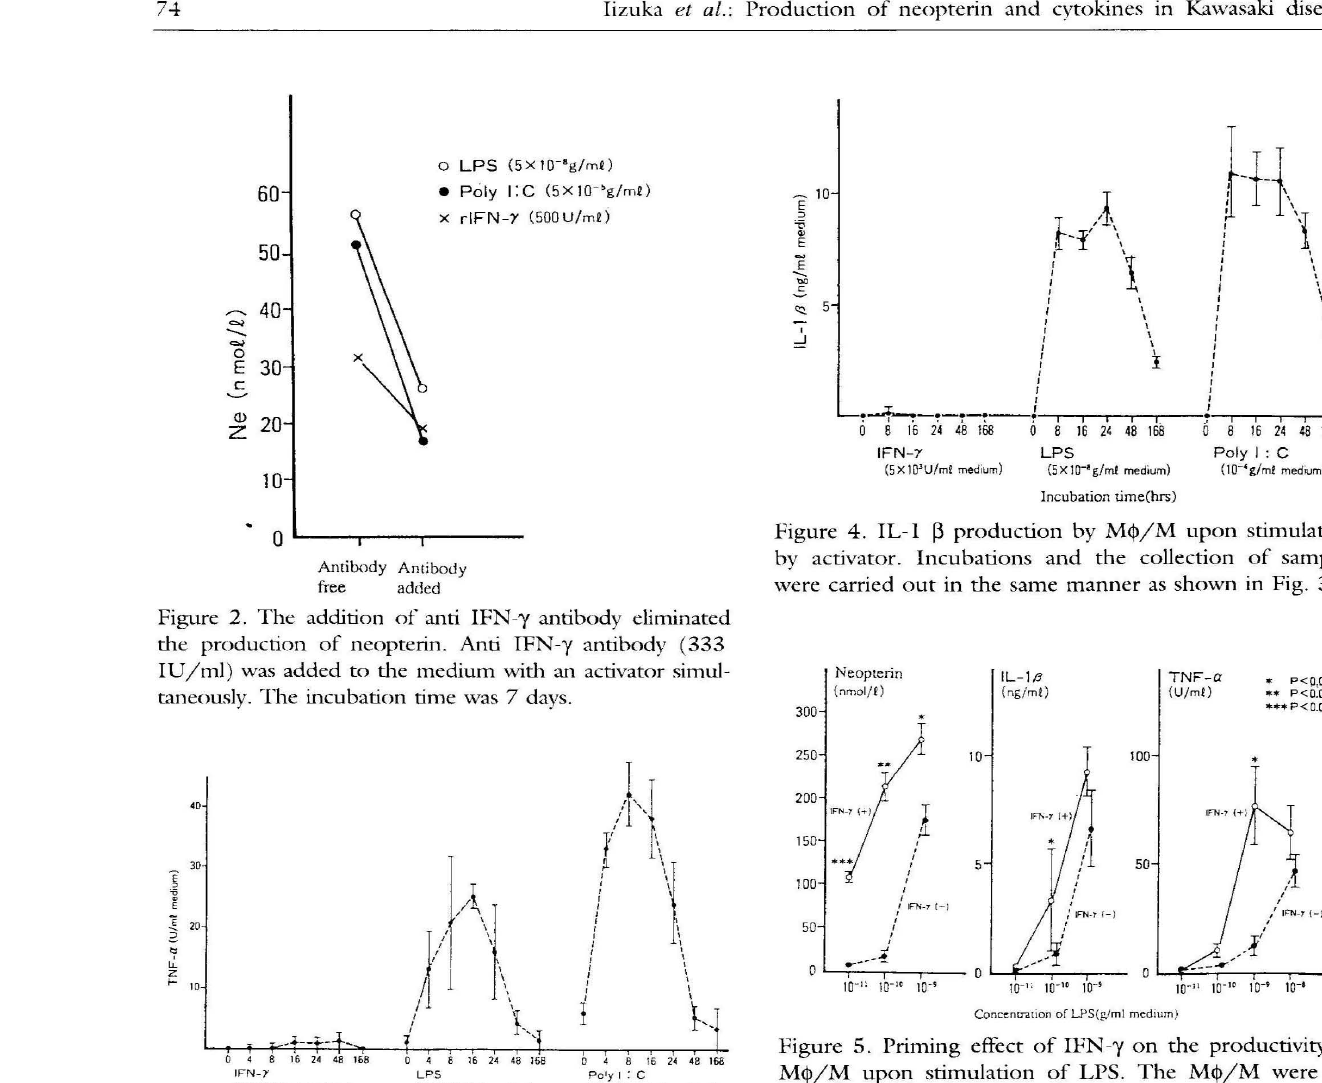
Figure 5. Priming effect of IrN-y on the productivity of M<p/M upon stimulation of LPS. The M<j>/M were in cubated upon simultaneous stimulations with low dose LPS and rlFN-y (l,OOOIU/ml). These figures were plotted from the maximum value of products during in cubation: neopterin values on the 7th day, TNF-a and IL-I 13 values 8 and 16 hr after incubation. neither TNF-Cf.. nor IL-l ~ were released. Howev er, after stimulation with either LPS (5x 10 Rg/ml) or Poly I:C (2.5 X 10 4 g/ml), both TNF-Cf.. and IL l ~ were released, the production peaking 8 or 16 hours after incubation.